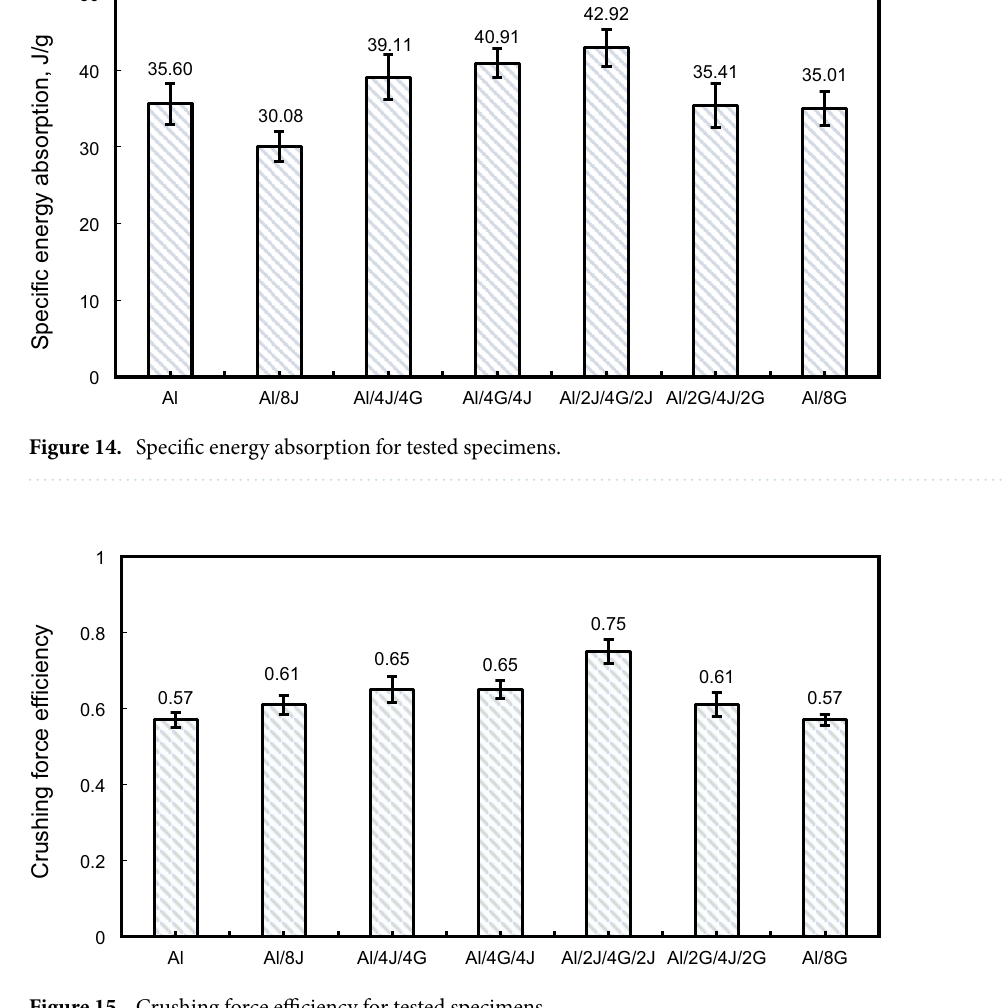
Figure 15. Crushing force efficiency for tested